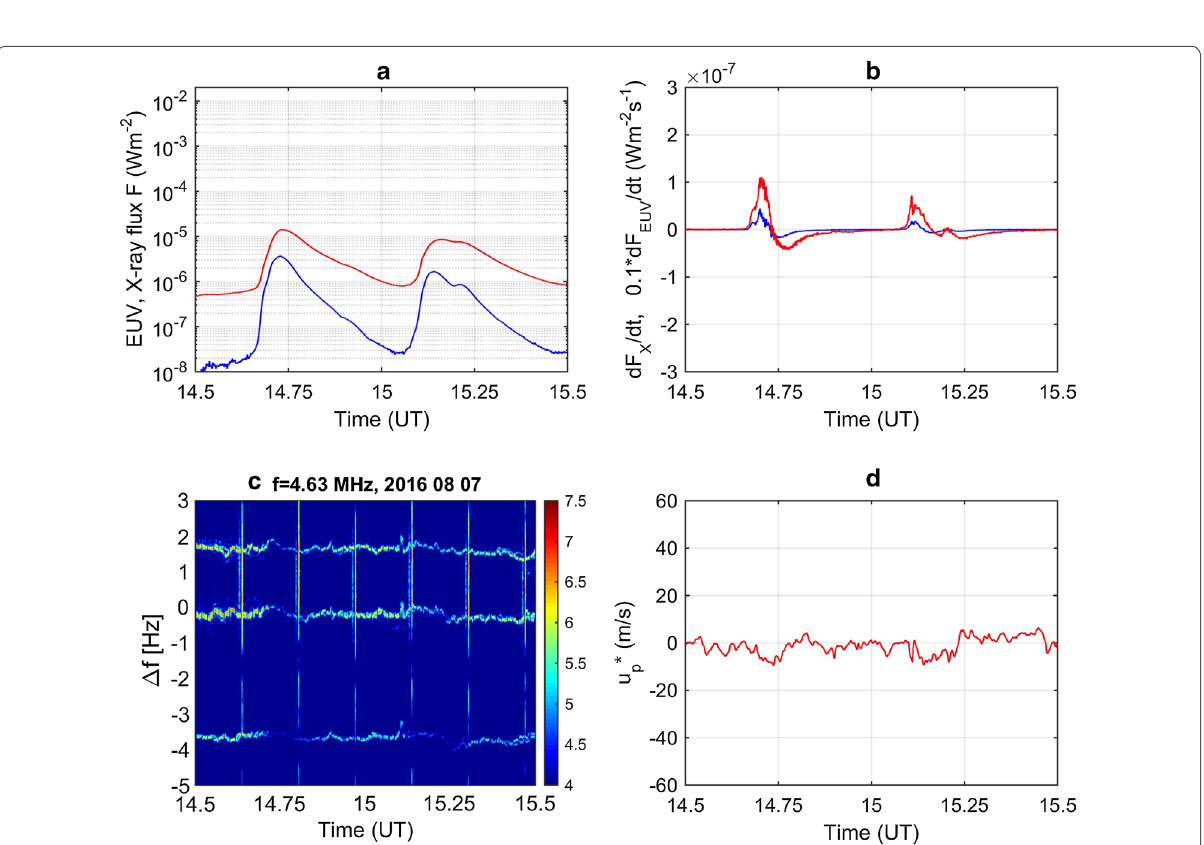
Fig. 10 X‑ray events on 7 August 2016 and their ionospheric responses. a X‑ray fluxes in the ranges 0.1–0.8 nm and 0.05–0.4 nm by red and blue, respectively, recorded from 14:30 to 15:30 UT. b Time derivatives of the X‑ray fluxes, dF X /dt, (red for 0.1–0.8 nm, blue for 0.05–0.4 nm). c Spectrogram recorded by CDSS in Tucumán from 14:30 to 15:30 UT. d Virtual plasma velocity u P* obtained by Eq. (3) for f